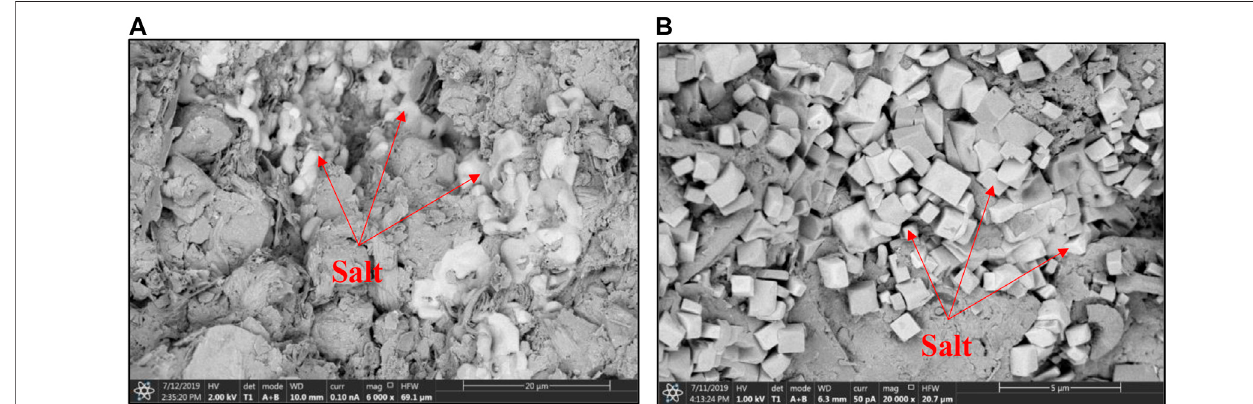
Frontiers in Energy Research |